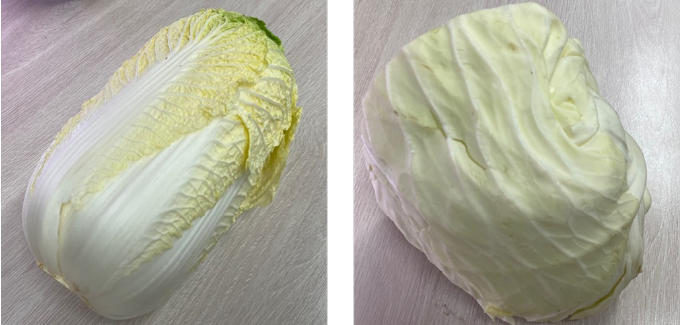
Figure 1. ( Left ) Napa cabbage, which we classify in fields; ( Right ) common cabbage in the West.